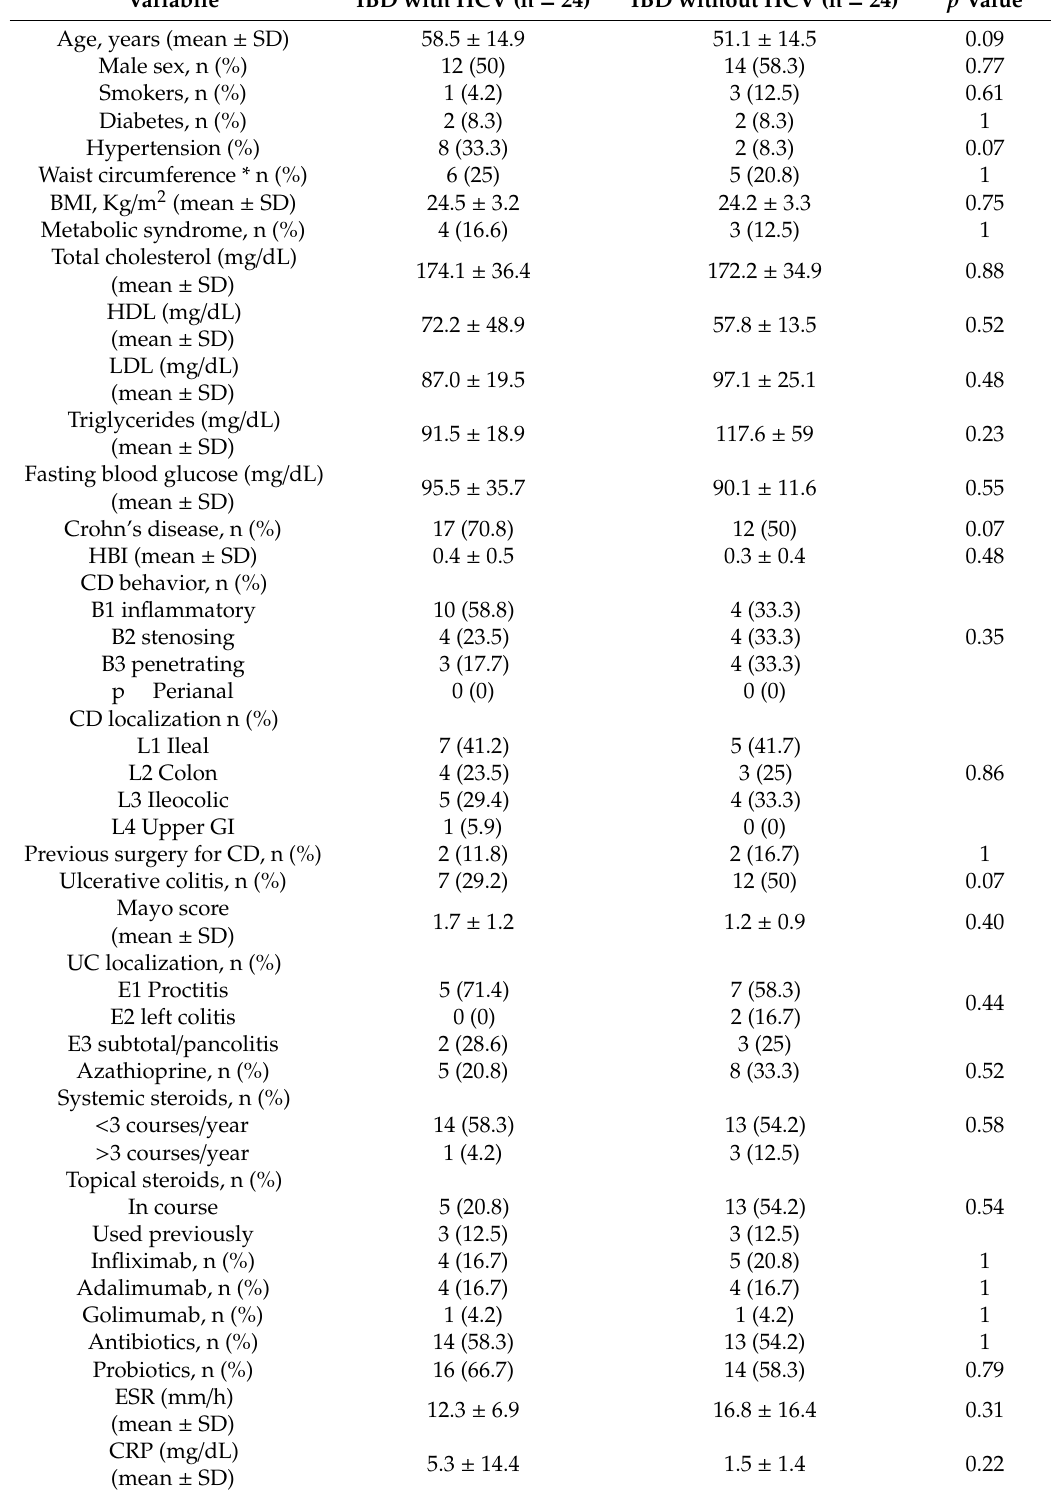
Table 1. Comparison of demographic, anthropometric and metabolic characteristics of patients with IBD with or without